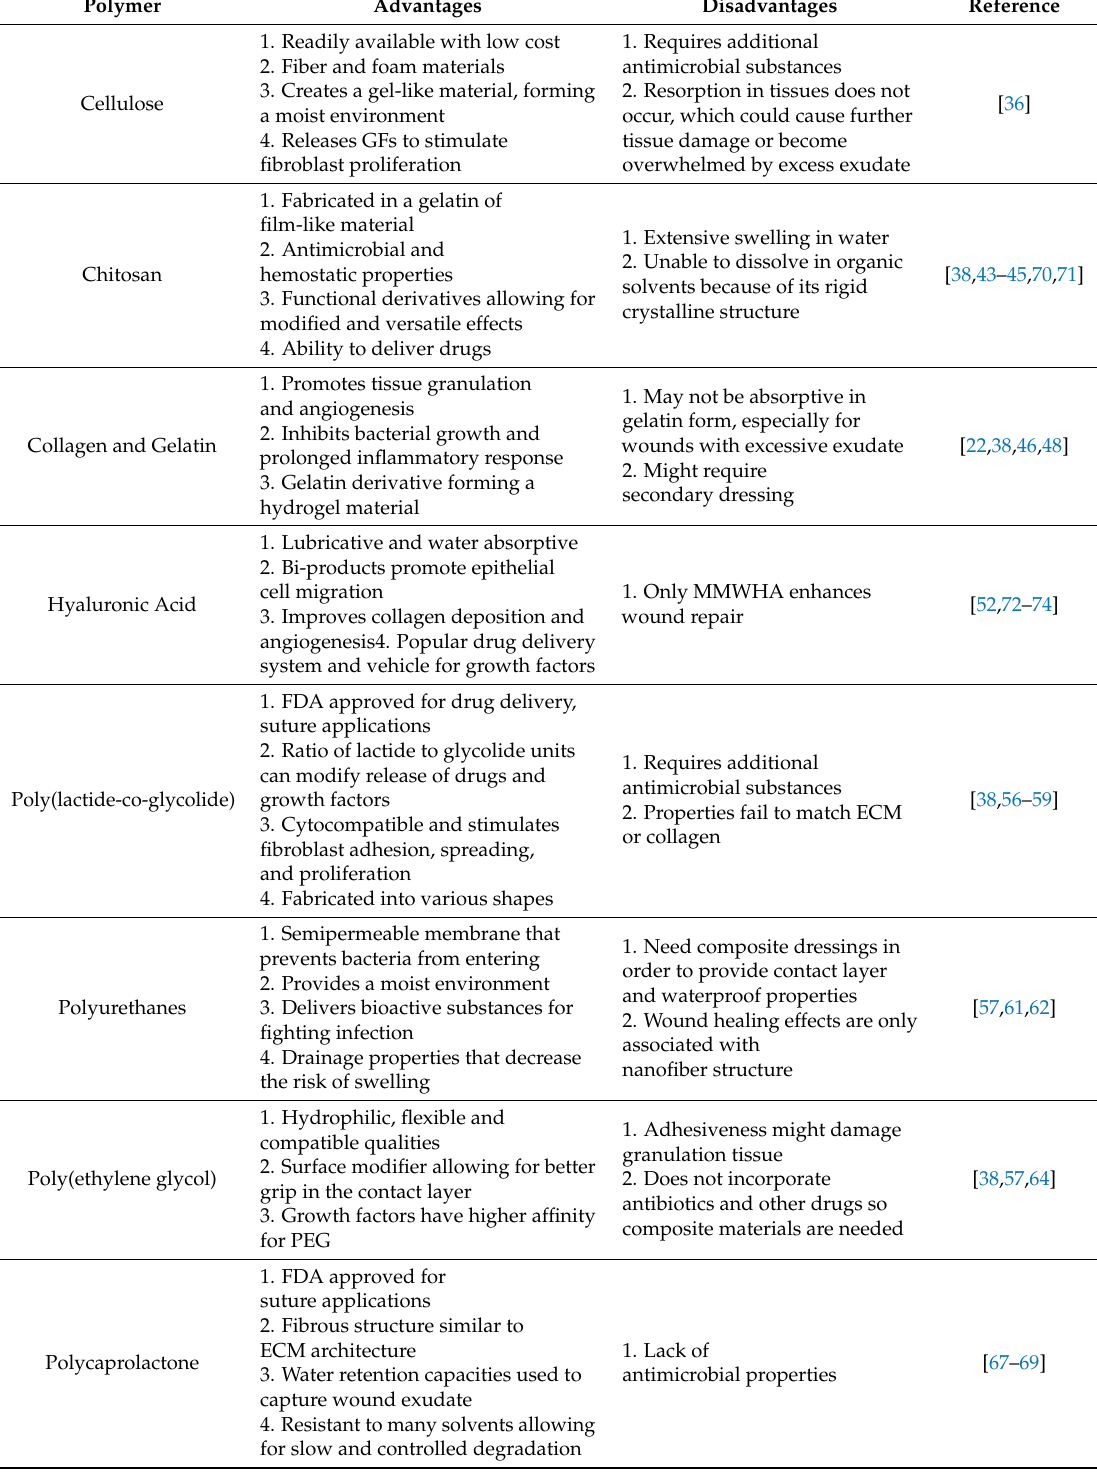
Table 2. Summary of Polymer-based Wound